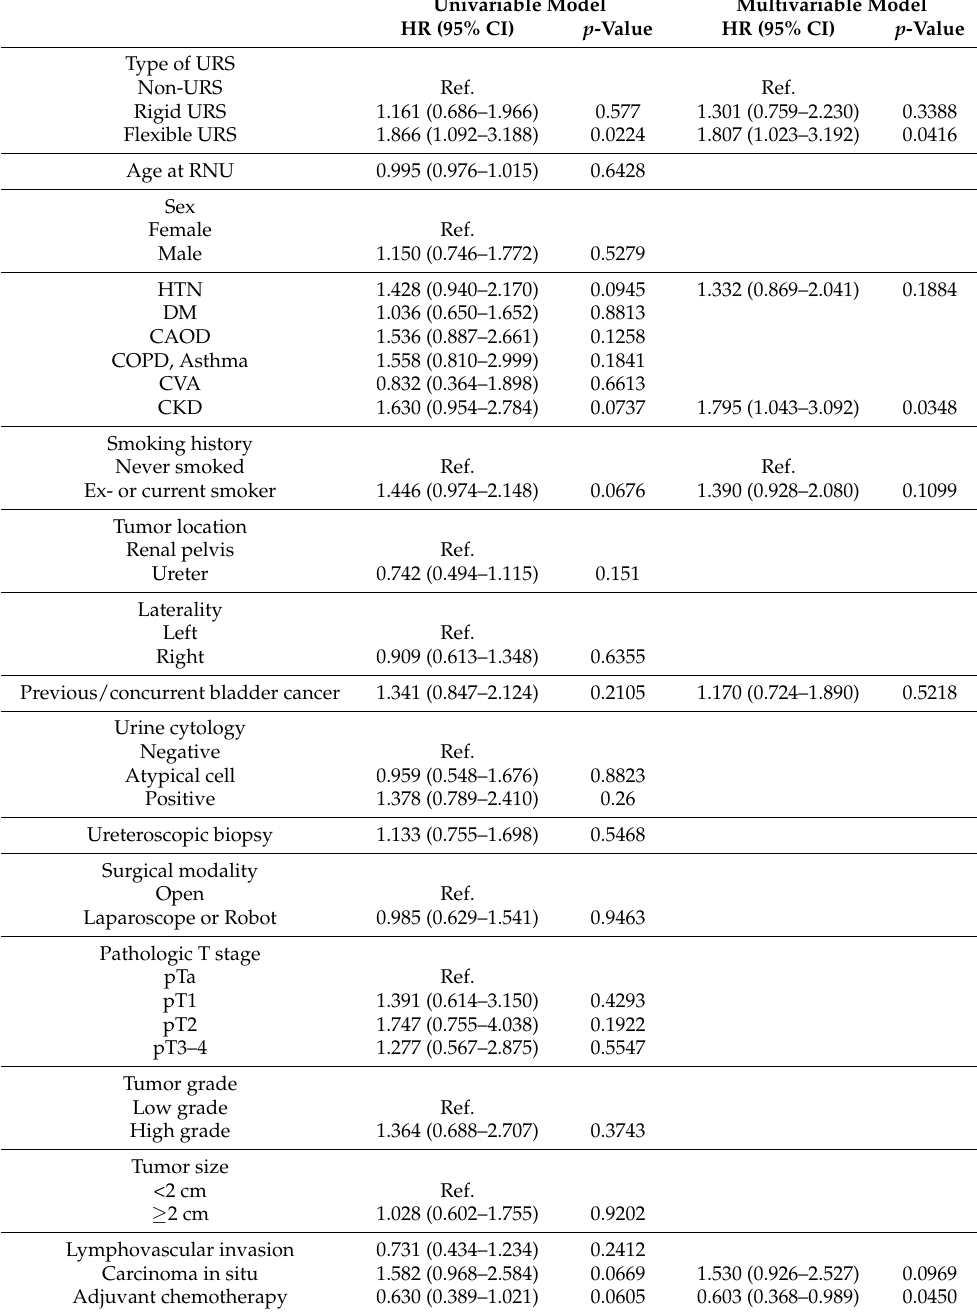
Table 3. Univariable and multivariable Cox regression